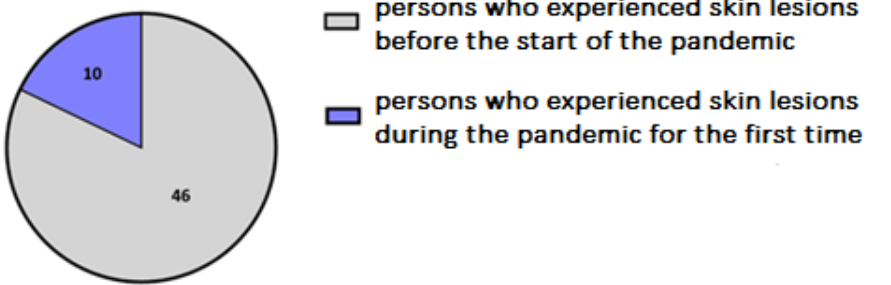
Figure 2. Division of the HE-derm group according to the time of diagnosis of the hand skin disease.